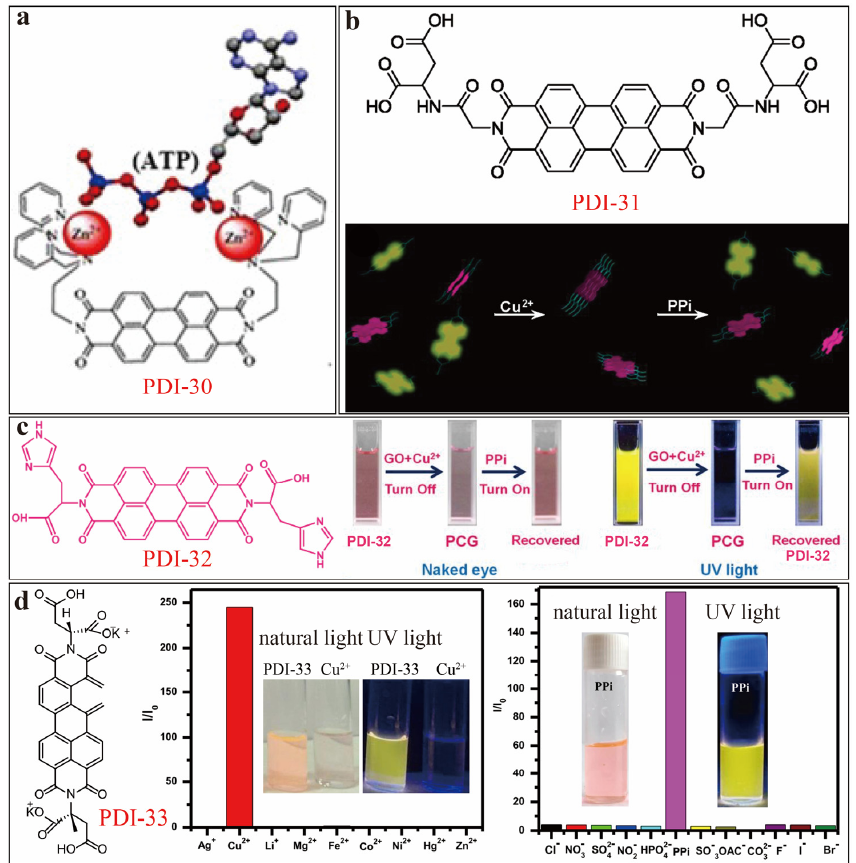
Figure 10. ( a ) Schematic illustration of sensing mechanism of PDI-30-Zn 2 + towards ATP. Reproduced